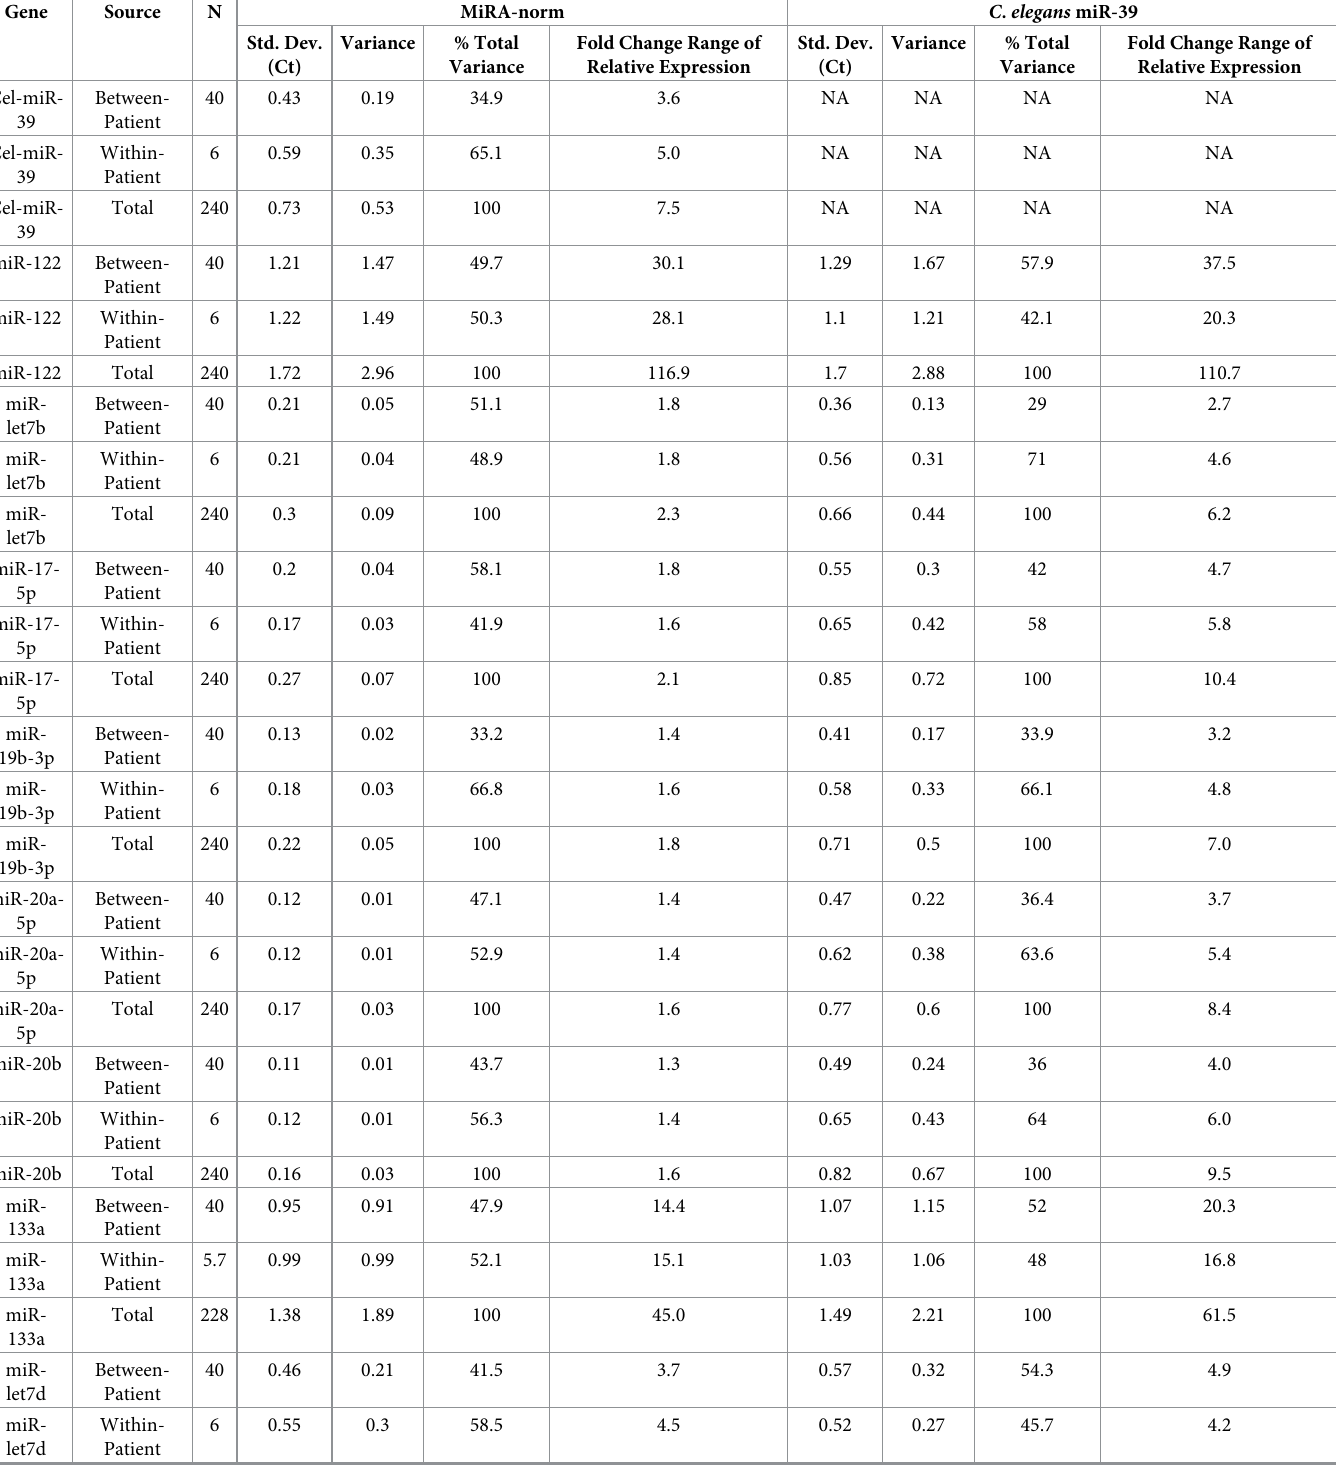
Table 3. Variance components, percent total variance, and fold change of relative expression for a subset of abundant miRNAs in serum from healthy volunteers. Gene Source N MiRA-norm C . elegans miR-39 Std. Dev. Variance % Total Fold Change Range of Std. Dev. Variance % Total Fold Change Range of (Ct) Variance Relative Expression (Ct) Variance Relative